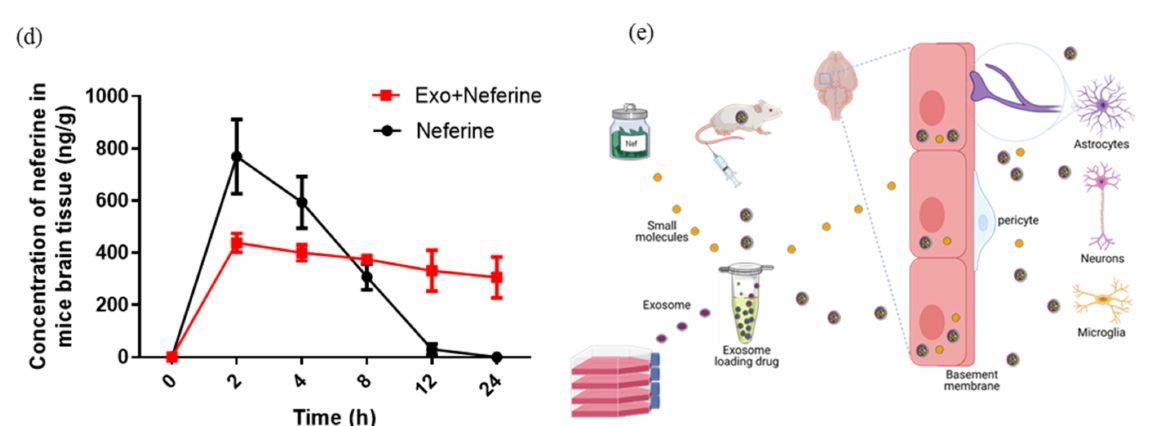
Figure 8. Exo-Nef effectively improved the motor behavioral deficiency of APP/PS1 mice and reduced the A β deposition in the mouse brain. ( a ) A rotarod test was used to observe the behavior of APP/PS1 double transgenic mice as described in the methodology section. ( b ) After the mice were sacrificed, the brain tissues were collected for further Western blot analysis on the level of the A β fibril normalized with β -actin. All of the experiments were performed as three independent experiments. ( c ) A dot blot analysis on the protein level of total A β in the mouse brain of different treatment groups was performed. ( d ) Pharmacokinetic study of neferine with or without the encapsulation by an exosome. ( e ) Schematic diagram showing the use of an exosome as a carrier for the selected neuroprotective herbal compound for crossing the blood–brain barrier in an AD mouse model. One-way ANOVA was used to compare the data: * p < 0.05, *** p <